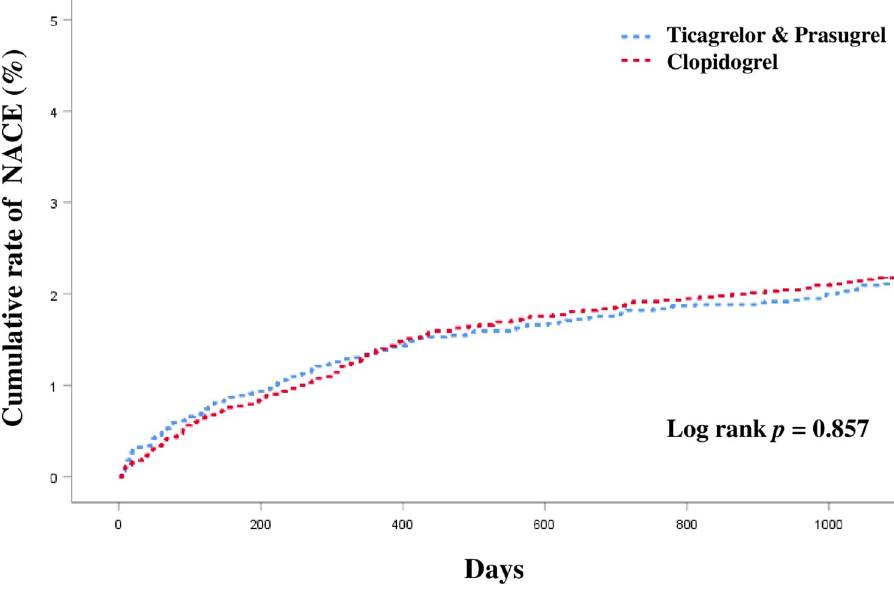
Fig 2. Kaplan–Meier curve for net adverse cardiac event (NACE) in clopidogerl group and ticagrelor or prasugrel group.